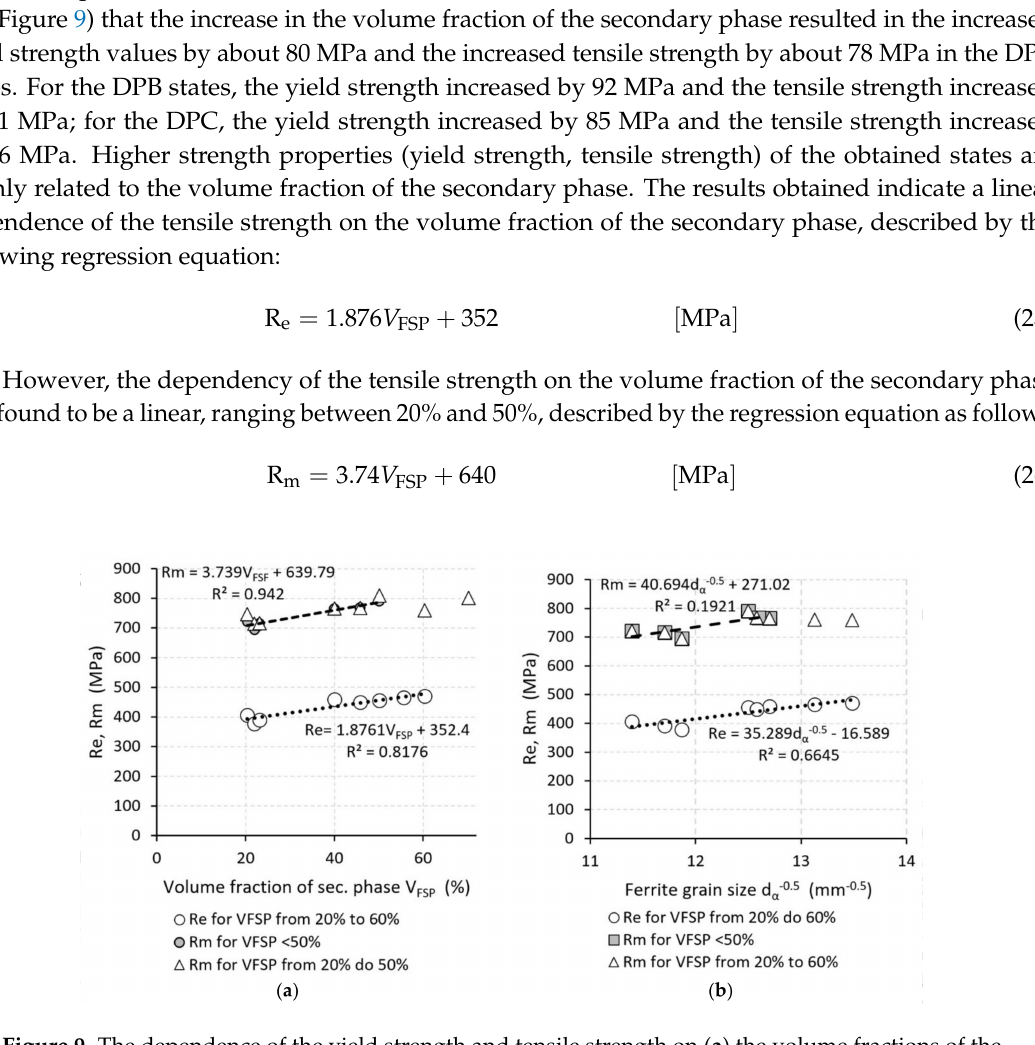
Figure 9. The dependence of the yield strength and tensile strength on ( a ) the volume fractions of the secondary phase; ( b ) the size of the ferritic